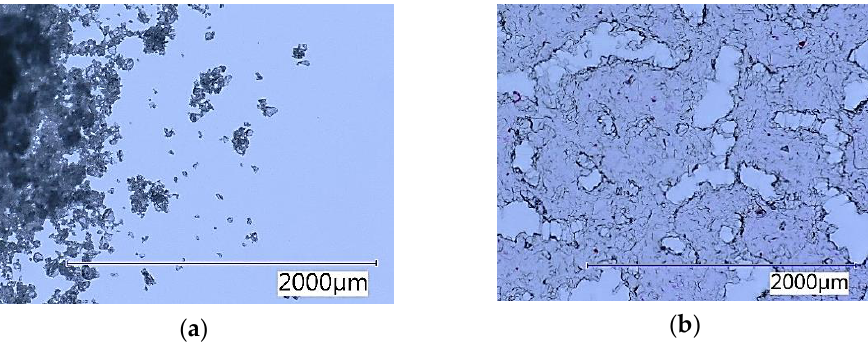
Figure 2. Structure of used SAP under the microscope with transmitted light: ( a ) dry SAP—magnification 150×; ( b ) SAP after water absorption and desorption magnification 150×.